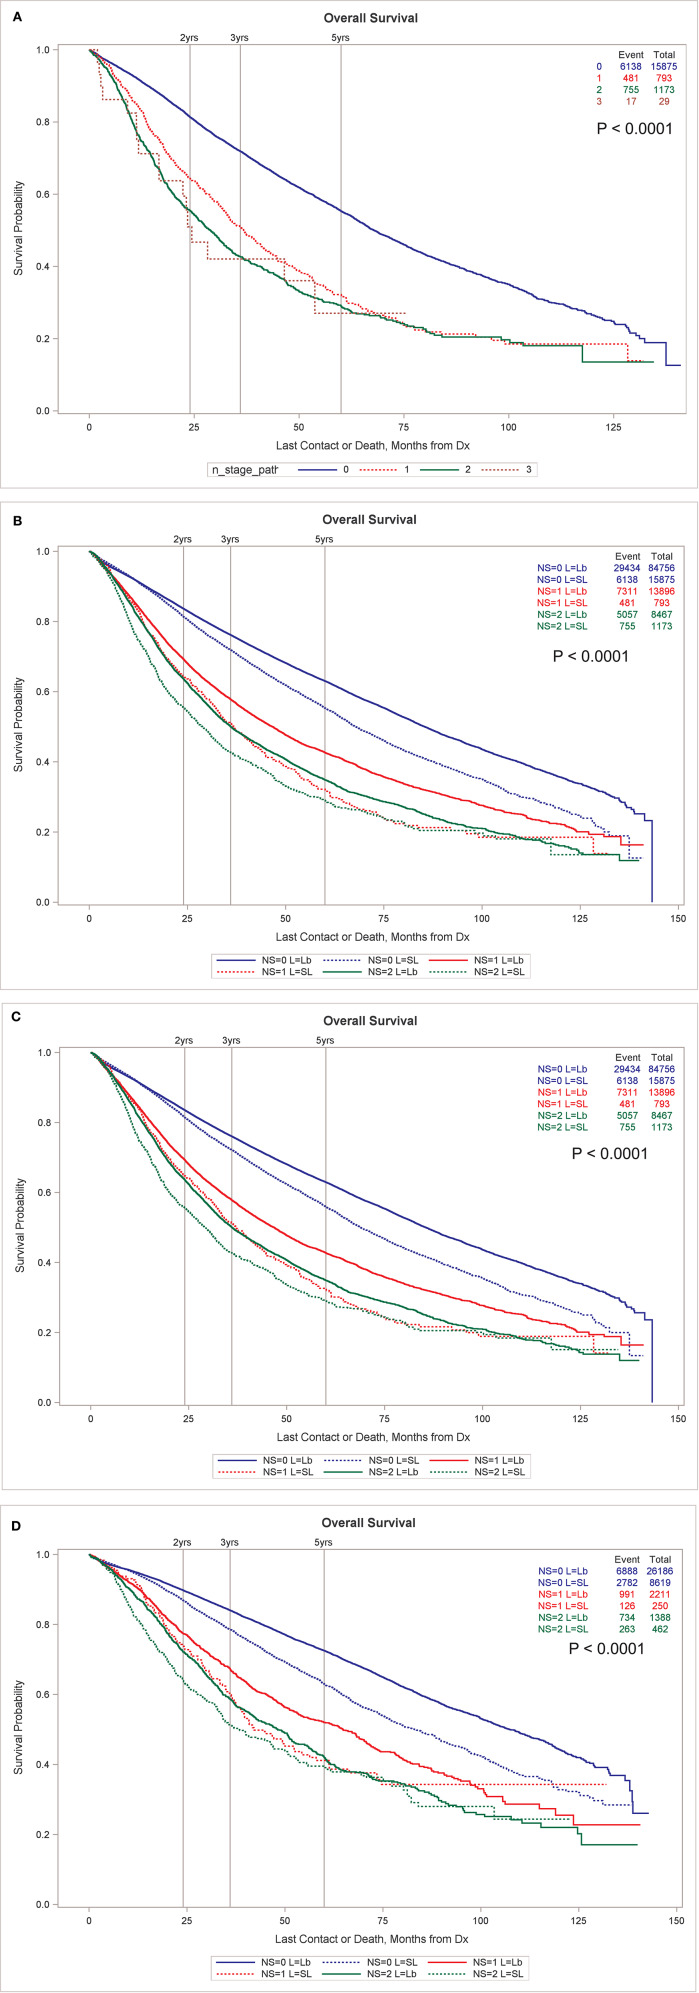
(A) OS by node stage in patients undergoing SLR. (B) OS by node stage by type of resection, sub-lobar vs. lobectomy, unmatched. Propensity match for OS by node stage by type of resection for all resected tumors (C) and only for those <2 cm in size (D). All node stages are pathologic in this figure. (B–D) exclude N3 nodes for clarity. (B–D) Including N3 nodes are available in Supplementary Material.